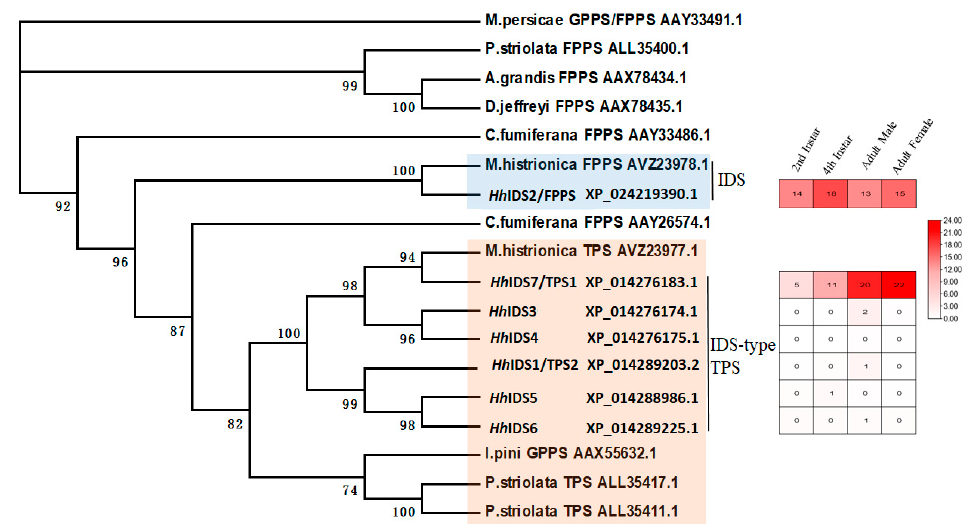
Figure 2. Phylogenetic tree of IDS genes from H. halys and other insects. Maximum likelihood phylogenetic tree was constructed by MEGA6.0 with the bootstrap value set to 1000 and the cut-off value set to 50%. TPM values of each IDS gene were calculated using transcriptomes of different developmental stages, sexes, and tissues of H. halys .